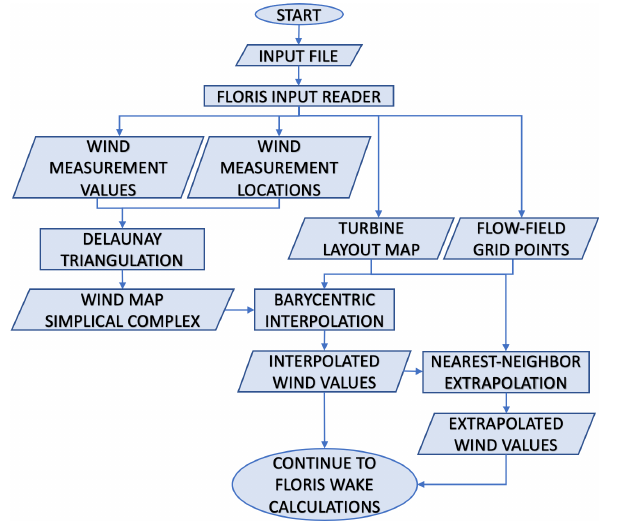
Figure 1. A diagram representing the processes performed during the initialization of the heterogeneous FLORIS